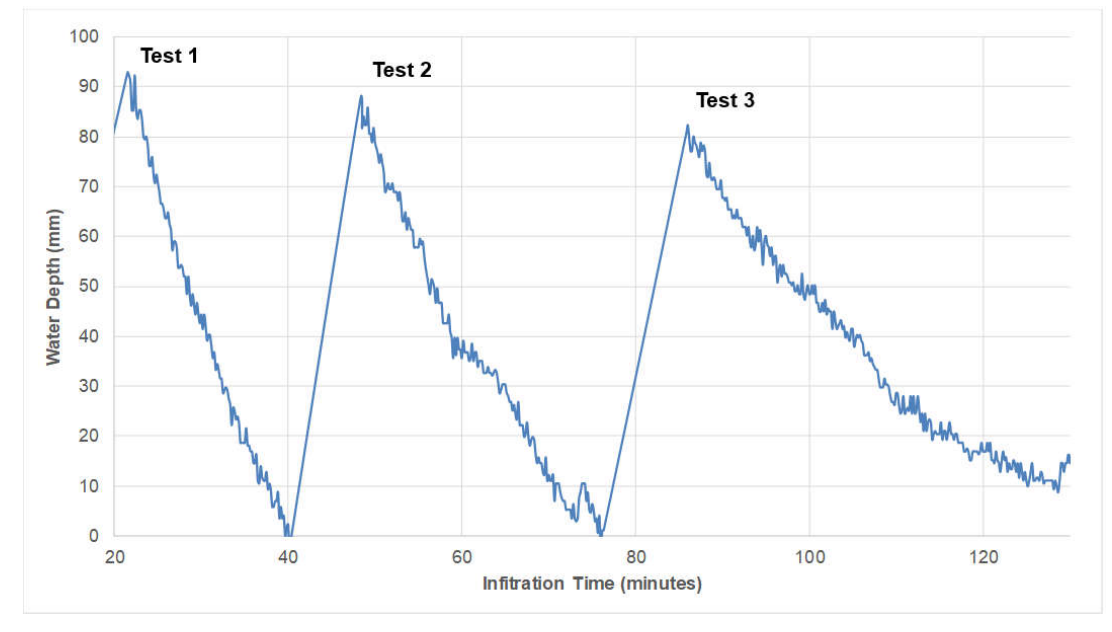
Figure 9. Results of FSIT testing at Goirle 2. Table 4. Reduction in infiltration rates between saturated and unsaturated FSIT tests at Groningen